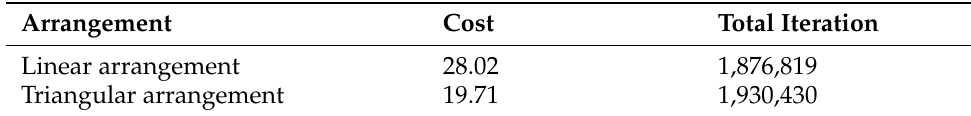
Table 5. Results of tests for the two arrangements. The final cost and the total number of cost function